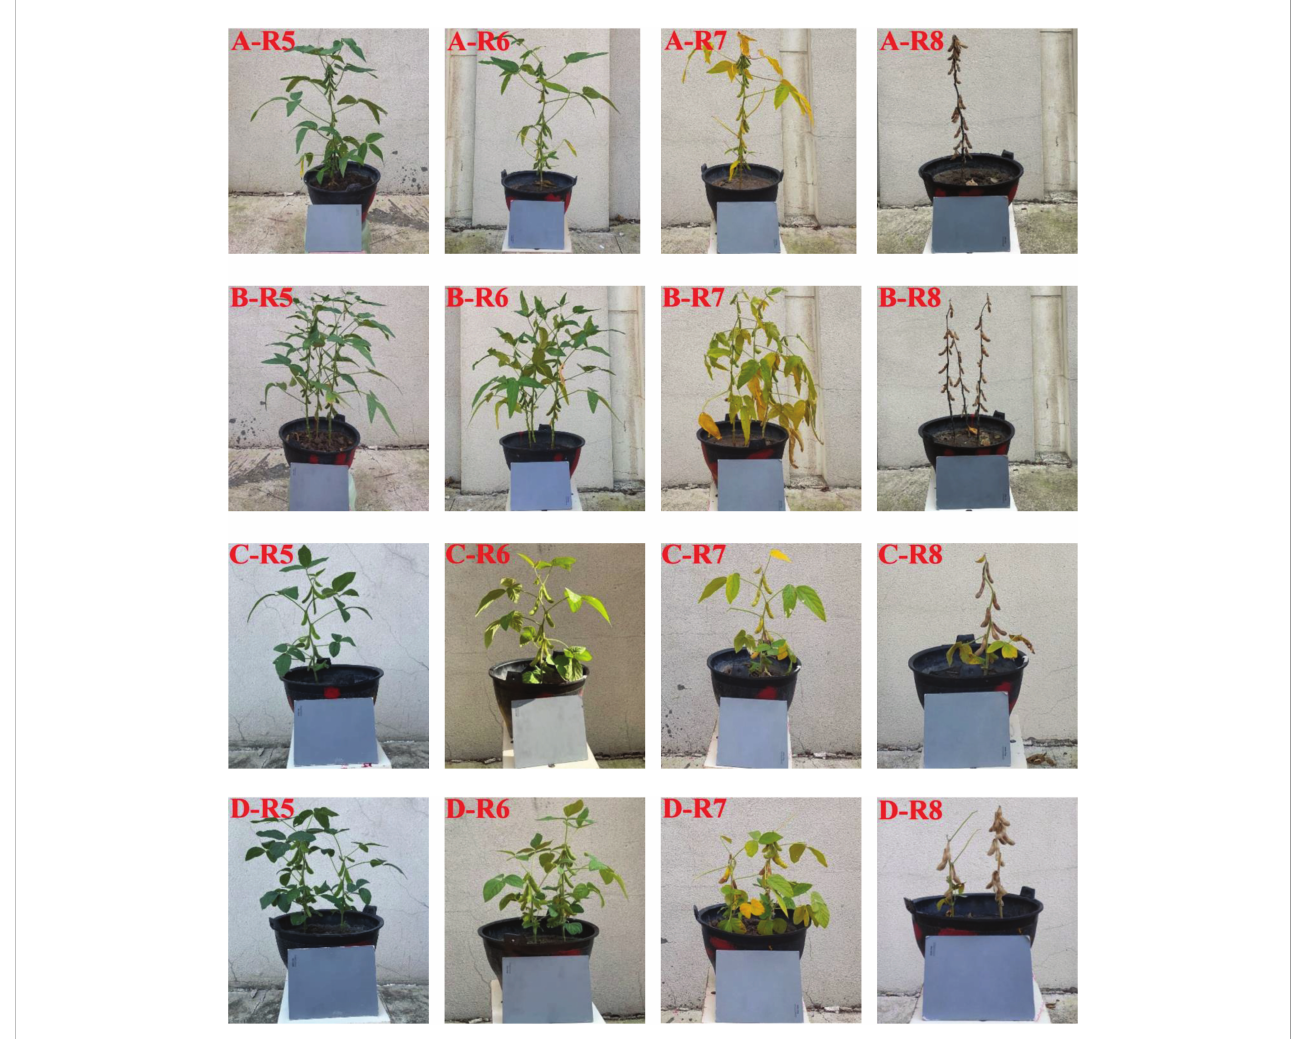
FIGURE 2 Soybean plants ’ images of two varieties in different growth stages (A) Single soybean plant of Suinong 26 ; (B) Multi soybean plants of Suinong 26; (C) Single soybean plant of Heihe 49; (D) Multi soybean plants of Heihe